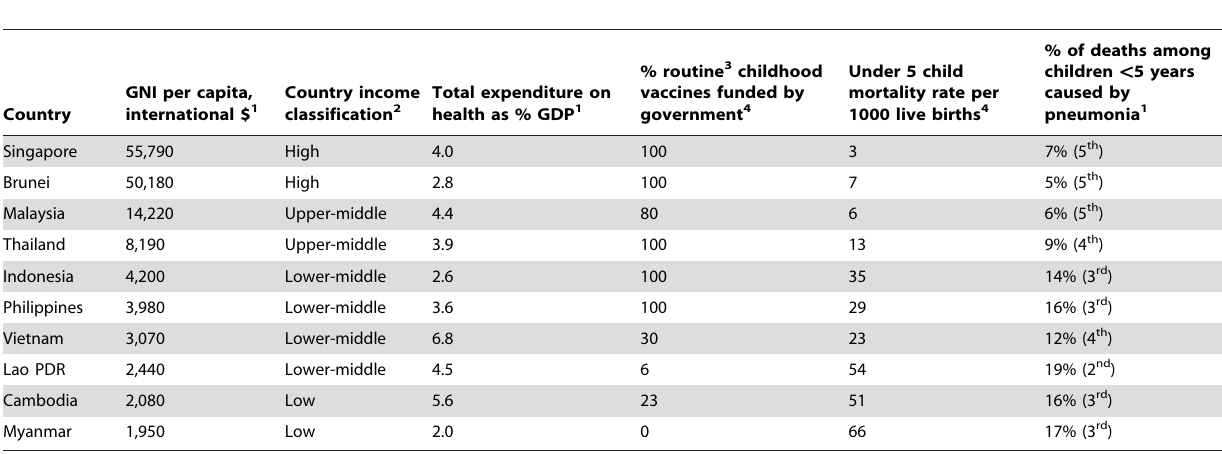
Table 1. Selected health, budgetary, and immunization statistics of the ten Southeast Asian countries surveyed.